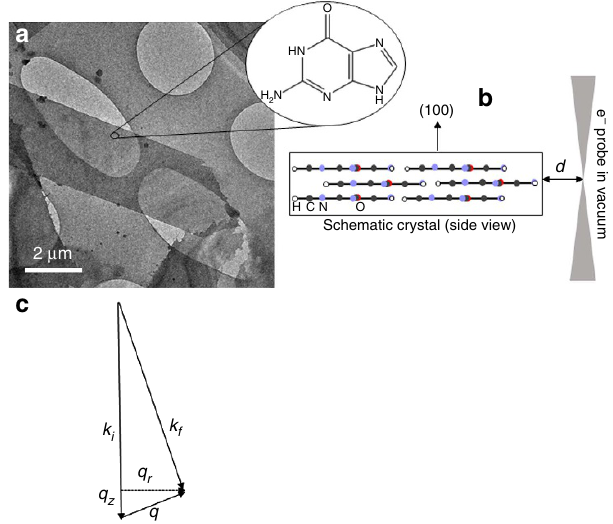
Figure 1 | Position of the electron beam with respect to the guanine crystal. ( a ) Low-magnification ‘top-view’ image of guanine crystals laying on holey carbon film. The long edges of the crystal are in the (010) direction using the unit cell of Hirsch et al. 37 ( a , inset) one schematic guanine molecule—the molecules are arranged in layers parallel to specimen surface to form the crystal as shown schematically from the side in b . Also shown in b is the position of the electron probe a distance d outside the crystal in the vacuum. ( c ) Schematic diagram showing the scattering wavevector for the electrons (side view). The energy loss is small compared with the energy of the incident electrons and the scattering angles are also small. The scattering wavevector can be decomposed into a component q z along the incident beam direction related to the energy loss (equation 1) and q r perpendicular to the incident beam direction. Under our experimental conditions, q r is much larger than q z